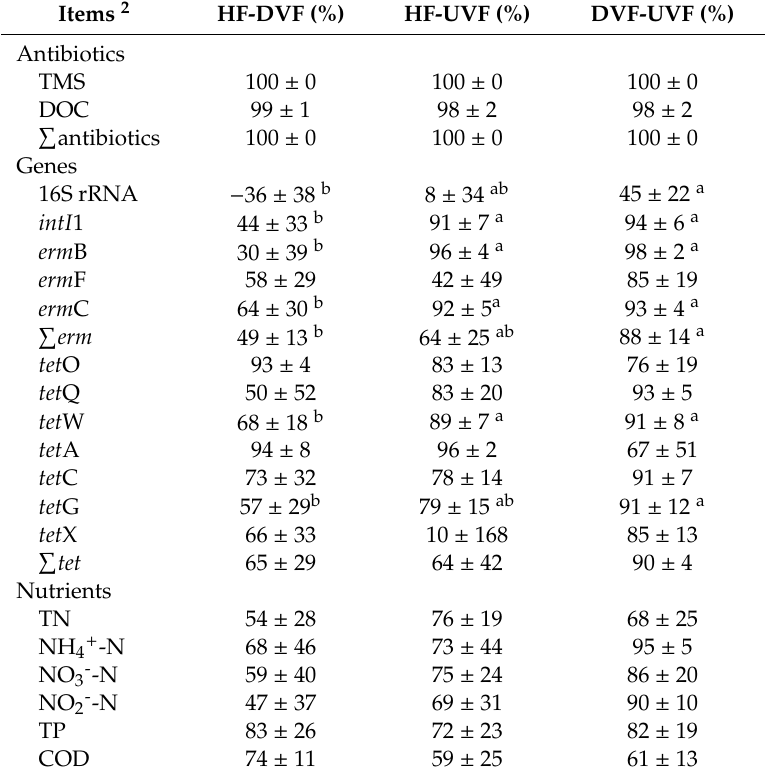
Table 1. Average removal e ffi ciencies of the studied antibiotics, antibiotic resistance genes, and nutrients obtained in each hybrid constructed wetland 1 Items 2 HF-DVF (%) HF-UVF (%) DVF-UVF (%)